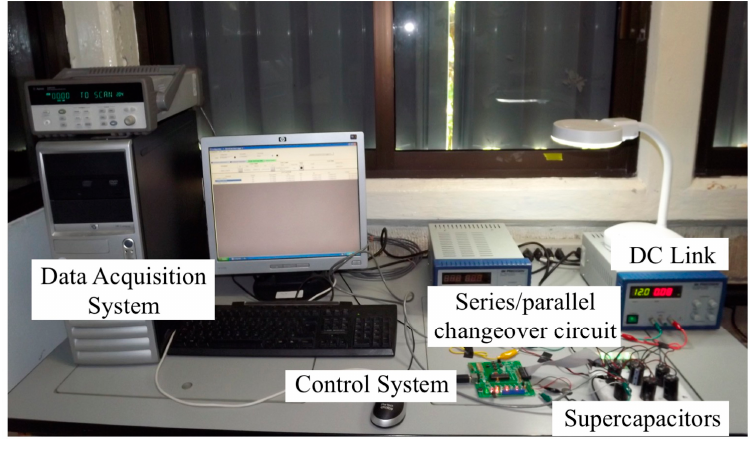
Figure 8. Test bank.